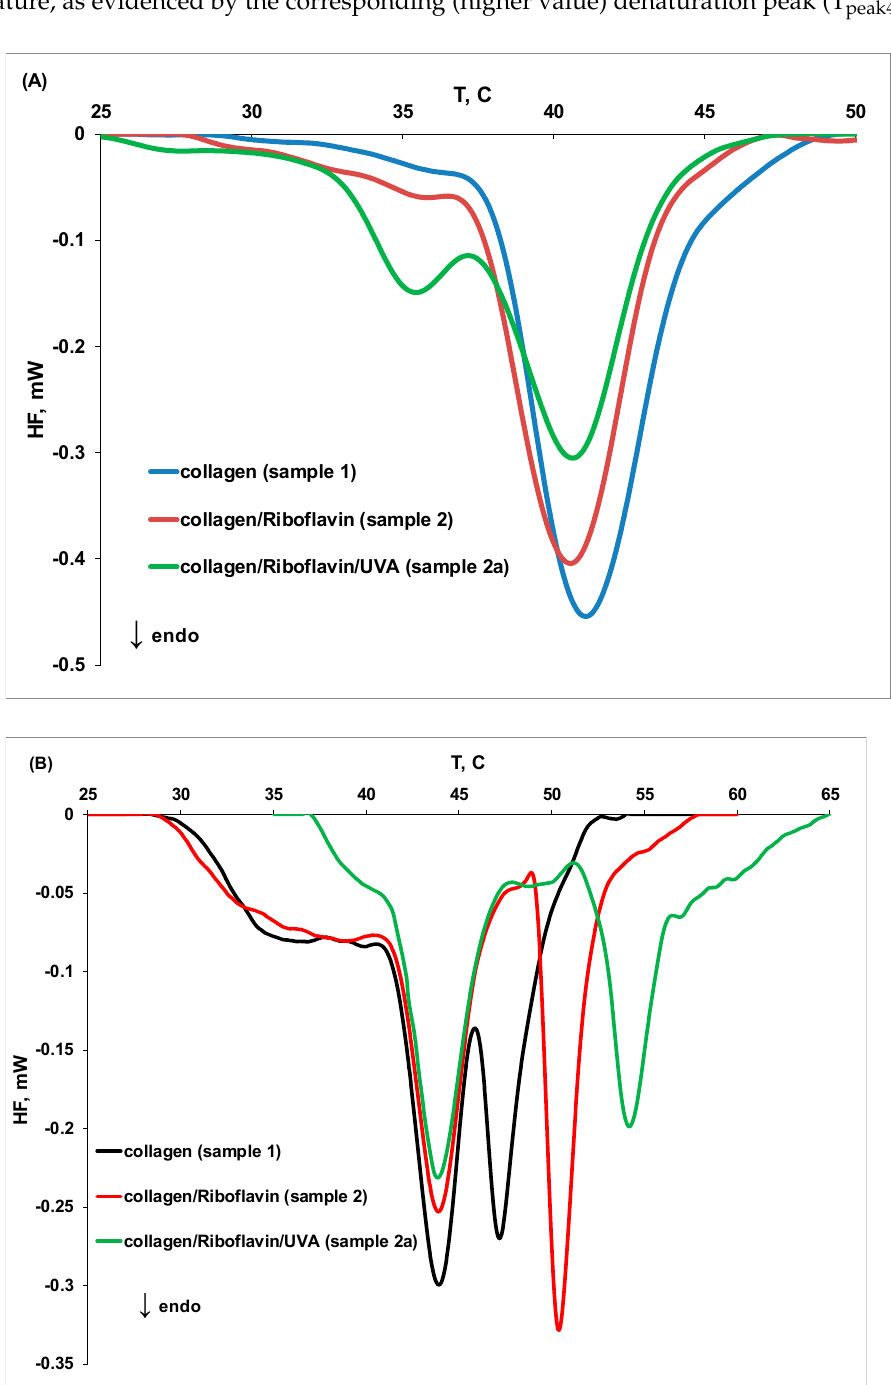
molecules [37]. Riboflavin also protects the new fibrillar collagen formed at higher temper- ature, as evidenced by the corresponding (higher value) denaturation peak (T peak4 ).